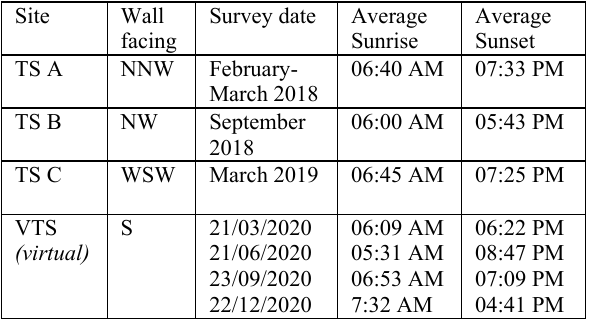
Table 1. Lighting characteristics of each test site. Average times of sunrise and sunset are reported for each acquisition period.